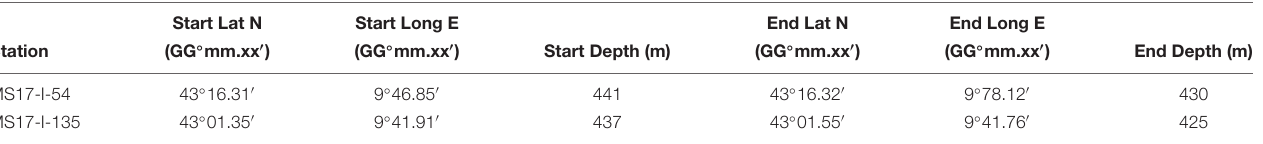
FIGURE 3 | T-S plot obtained from 20 depth profiles sourced from the World Ocean Atlas 2018 (WOA18) database in the area of the Corsica Channel (red square: 43.375 ◦ N-9.125 ◦ E; 43.375 ◦ N-10.625 ◦ E; 42.625 ◦ N-9.125 ◦ E; 42.625 ◦ N-10.625 ◦ E). Isopycnals are calculated with the reference pressure at 0 m ( σ 0). MAW, Modified Atlantic Water; LIW, Levantine Intermediate Water; TDW, Tyrrhenian Deep Water; WMDW, Western Mediterranean Deep Water. The plot was created using Ocean Data View (Schlitzer, R., Ocean Data View, http://odw.awi.de, 2020). TABLE 1 | Remotely operated vehicle (ROV)